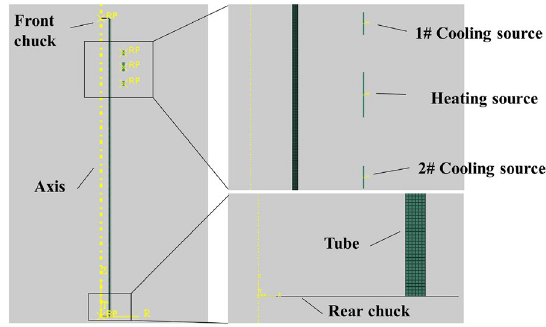
Figure 5 Schematic diagrams of FEM